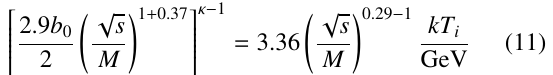
Figure 2. Rapidity density distribution at √ s = 7000 GeV. Lines are eq.(6) for a = 1.0, 5.0, 10.0, 15.0, 20.0 and 25.0. Experimen- tal data in the most forward region are the pseudo-rapidity den- sity from TOTEM (open triangles). Those in the central region are from ATLAS (full triangles) and CMS (open circles) experi- ments.